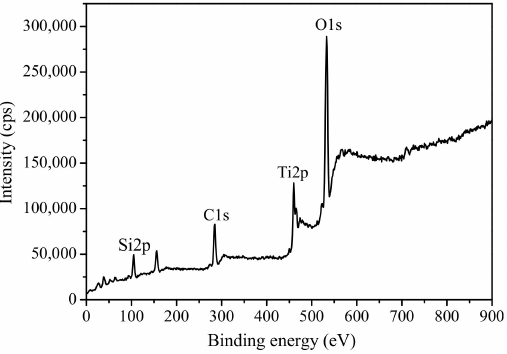
Figure 3. XPS survey spectra of the Ba(II)/TiO 2 –MCM-41 composite.